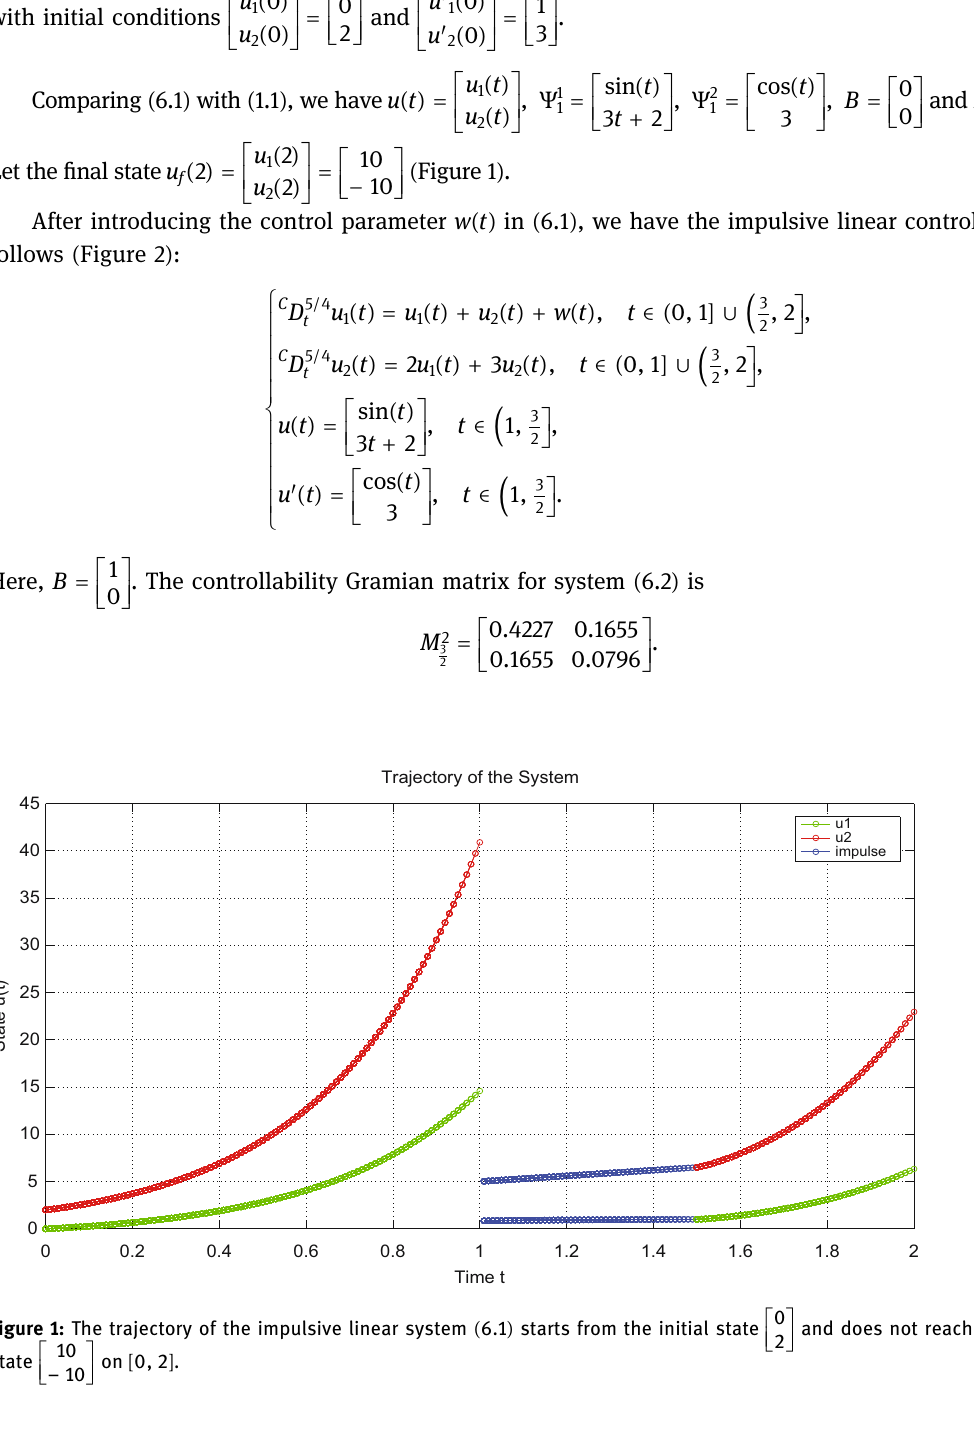
0   and does not reach the fi nal   2